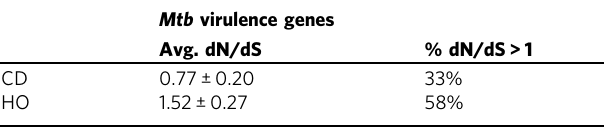
Mutation rates of virulence genes were analyzed by gene orientation (15 co-directional and 12 head-on core genes). Student ’ s t test p = 0.035 for HO vs. CD average dN/dS values